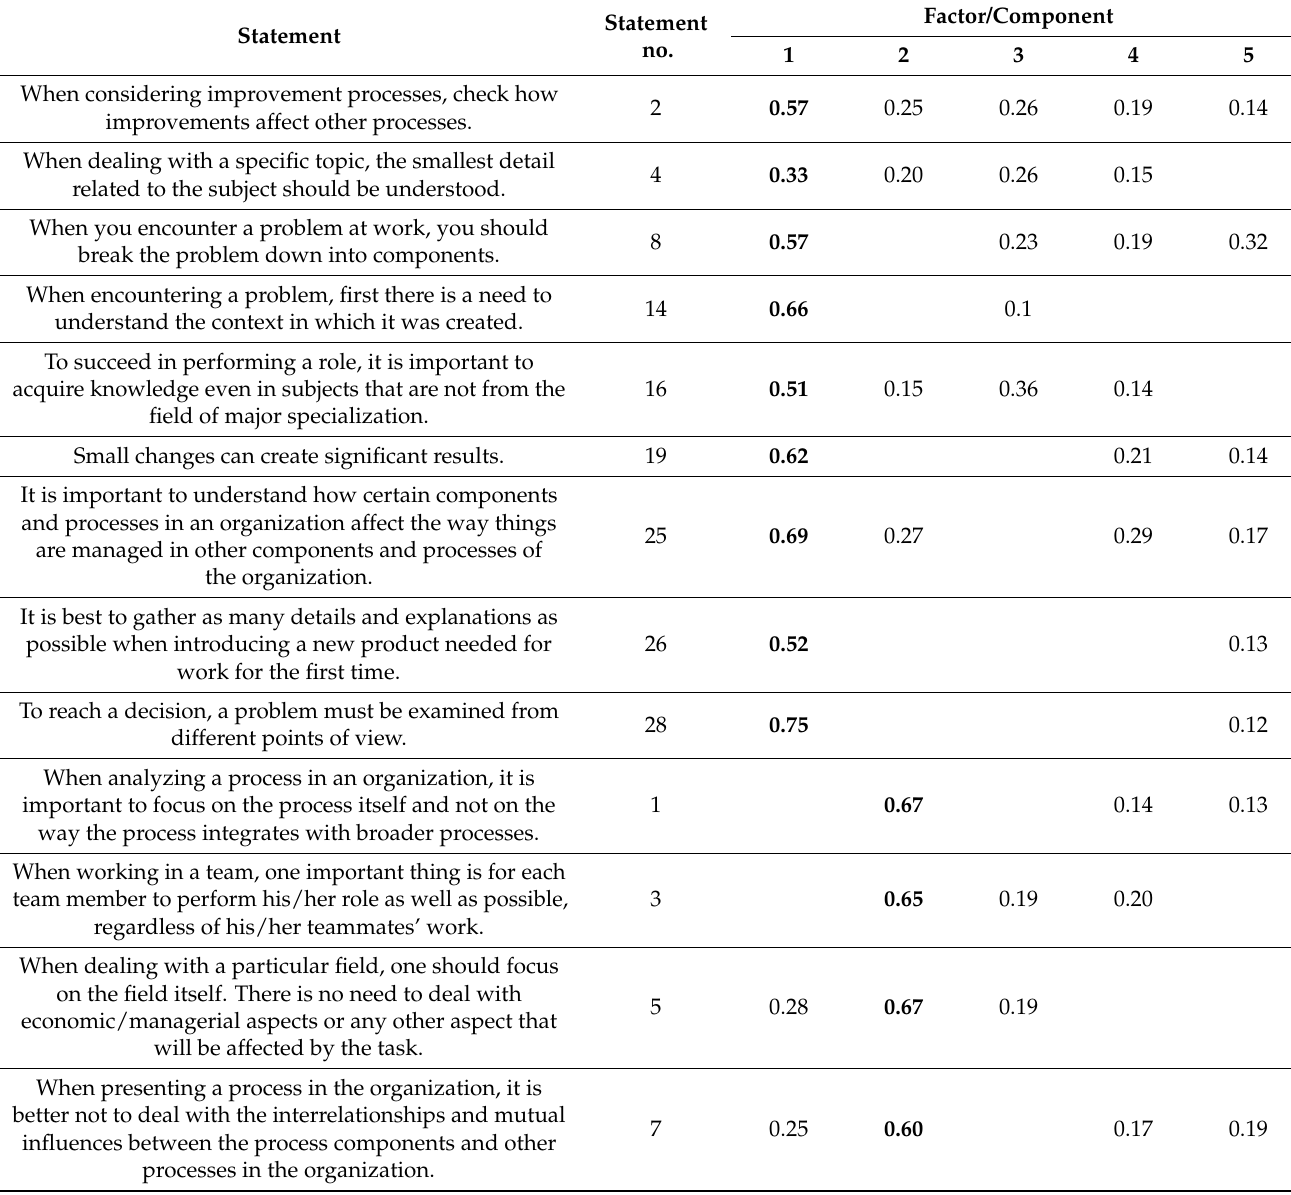
Table 3. Rotated component